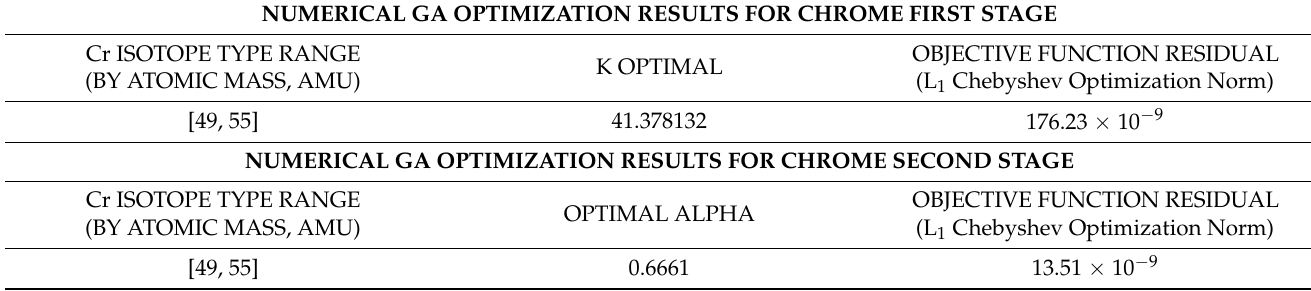
Table 2. Numerical results for Chrome using the GA optimization method.